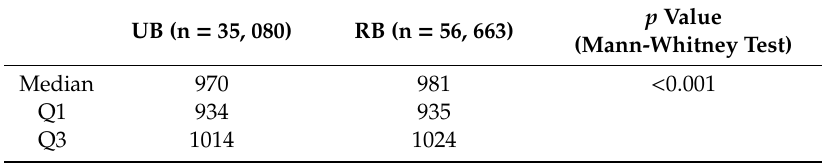
Table 2. Index of Relative Socio-Economic Advantage and Disadvantage (IRSAD) scores of the postcode of owners of dogs reported to be recognised breeds (RB) and unrecognised breeds (UB). UB (n = 35, 080)